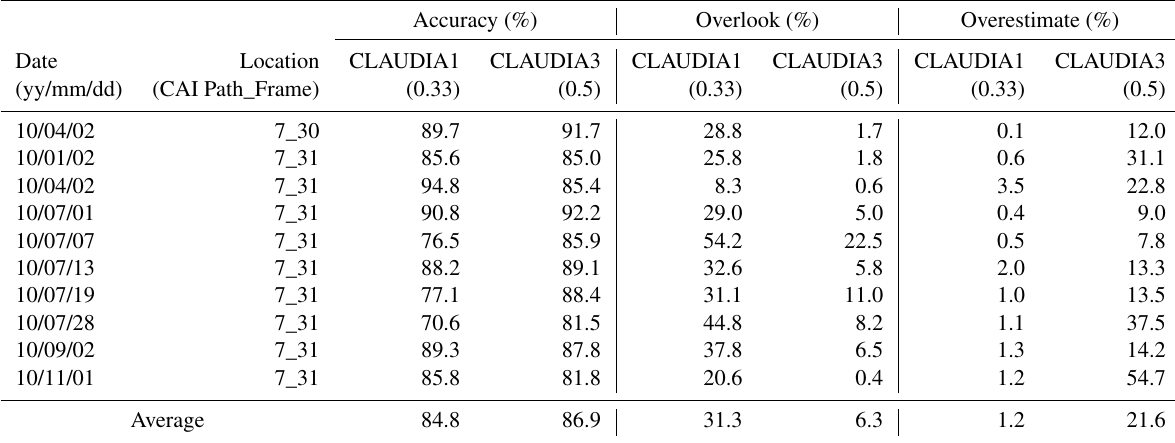
Table 7. Results for integrated-CCL thresholds of 0.33 for CLAUDIA1–CAI and 0.5 for CLAUDIA3–CAI in Borneo.